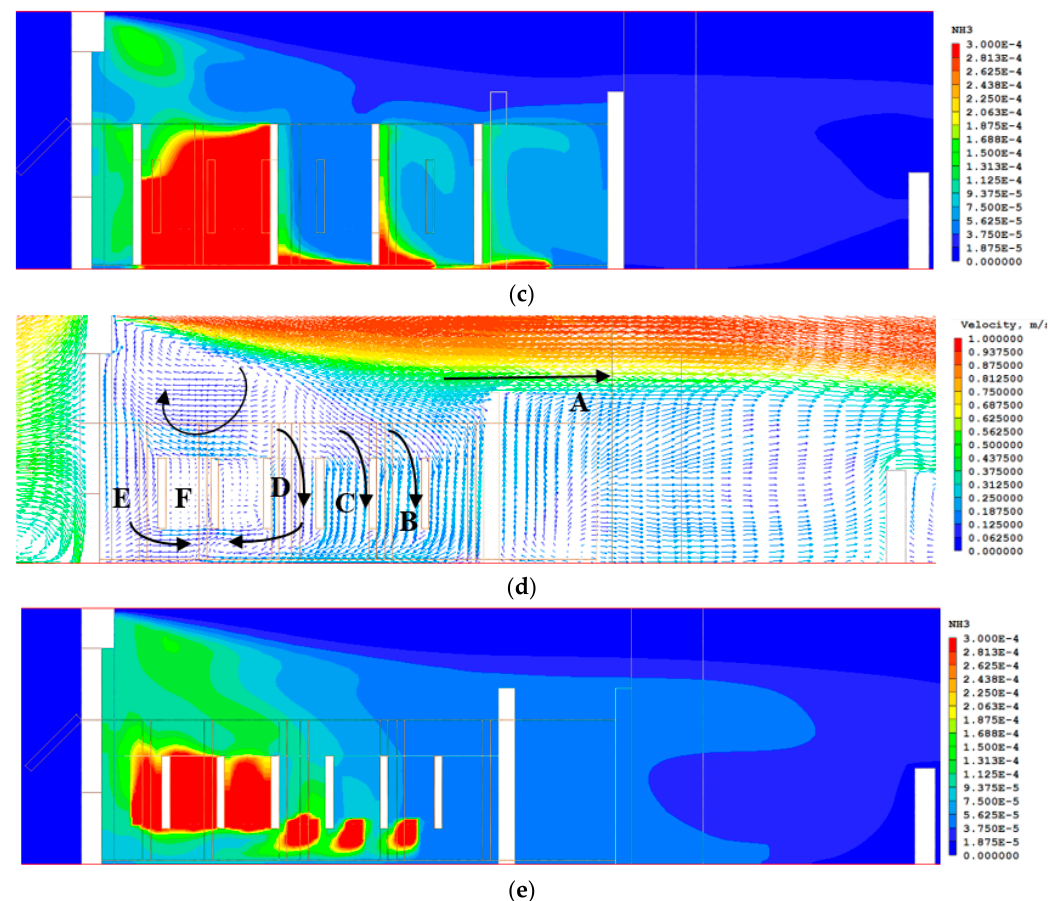
Figure 5. Indoor flow fields and NH 3 concentration (PPMV) distributions for north wind (window configuration: W2 (Table 1c); the opening angle θ is 45°; the outdoor wind speed is 1 m/s). ( a ) Flow field in aisle in the women’s restroom (Figure 1c, section A). ( b ) Flow field in toilet area in the women’s